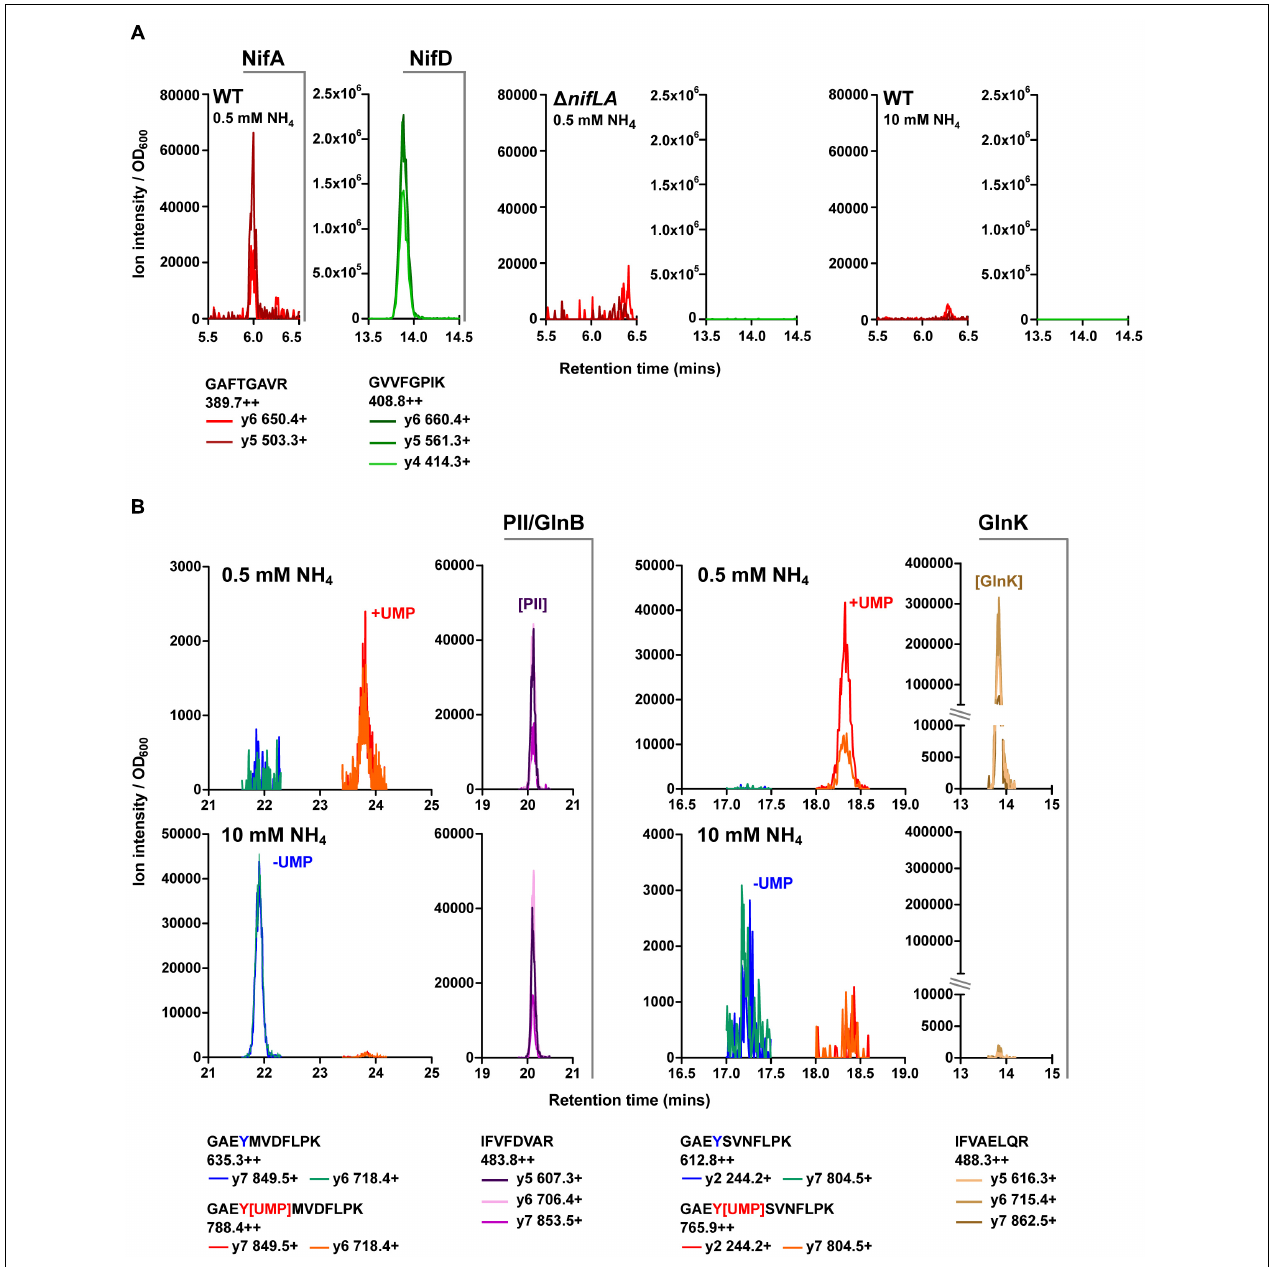
FIGURE 3 | Validation of key Nif and Ntr peptides. Retention time specific LC–MS peaks corresponding to candidate peptides (see Supplementary Data 1 ) in representative biological test samples: diazotrophic (wild-type, 0.5 mM NH 4 Cl), non-diazotrophic/N limiting ( (cid:49) nifLA , 0.5 mM NH 4 Cl) and N-replete (wild-type, 10 mM NH 4 Cl). Multiple daughter y-ion fragments (+) are shown for each parent ion (++), along with the corresponding m/z values. Peak ion intensity is normalised to sample OD 600 for relative quantification between samples. (A) NifD and NifA. (B) GlnB and GlnK. Non-modifiable peptides are indicative of relative PII-protein abundance between samples. Peaks at discrete retention times represent uridylylated (+UMP; red/orange) and non-uridylylated (–UMP; blue/green) forms of modifiable peptides. Note variable y -axis